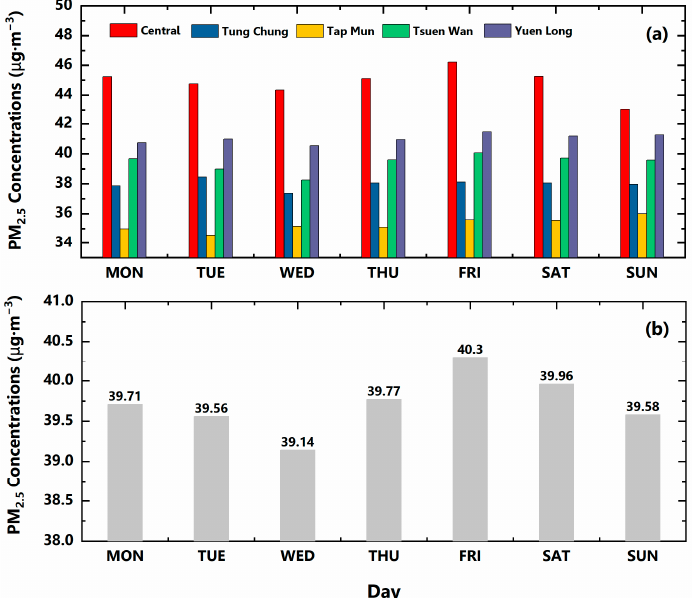
Figure 4. Four-year (2005–2008) mean PM 2.5 concentrations for weekdays and weekends with